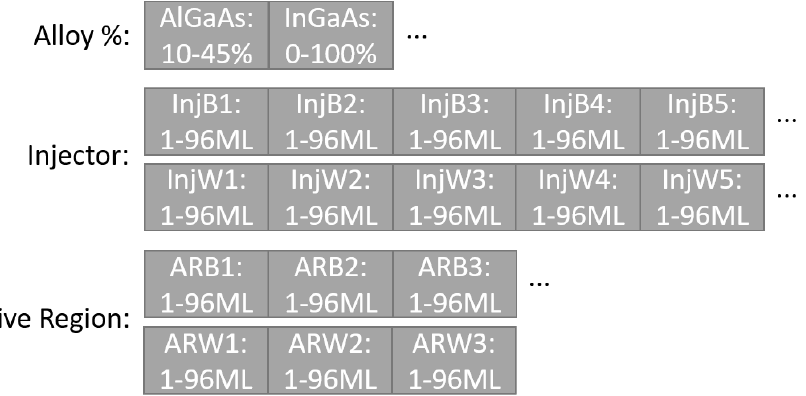
Figure 2. Generic gene sequence with value ranges.